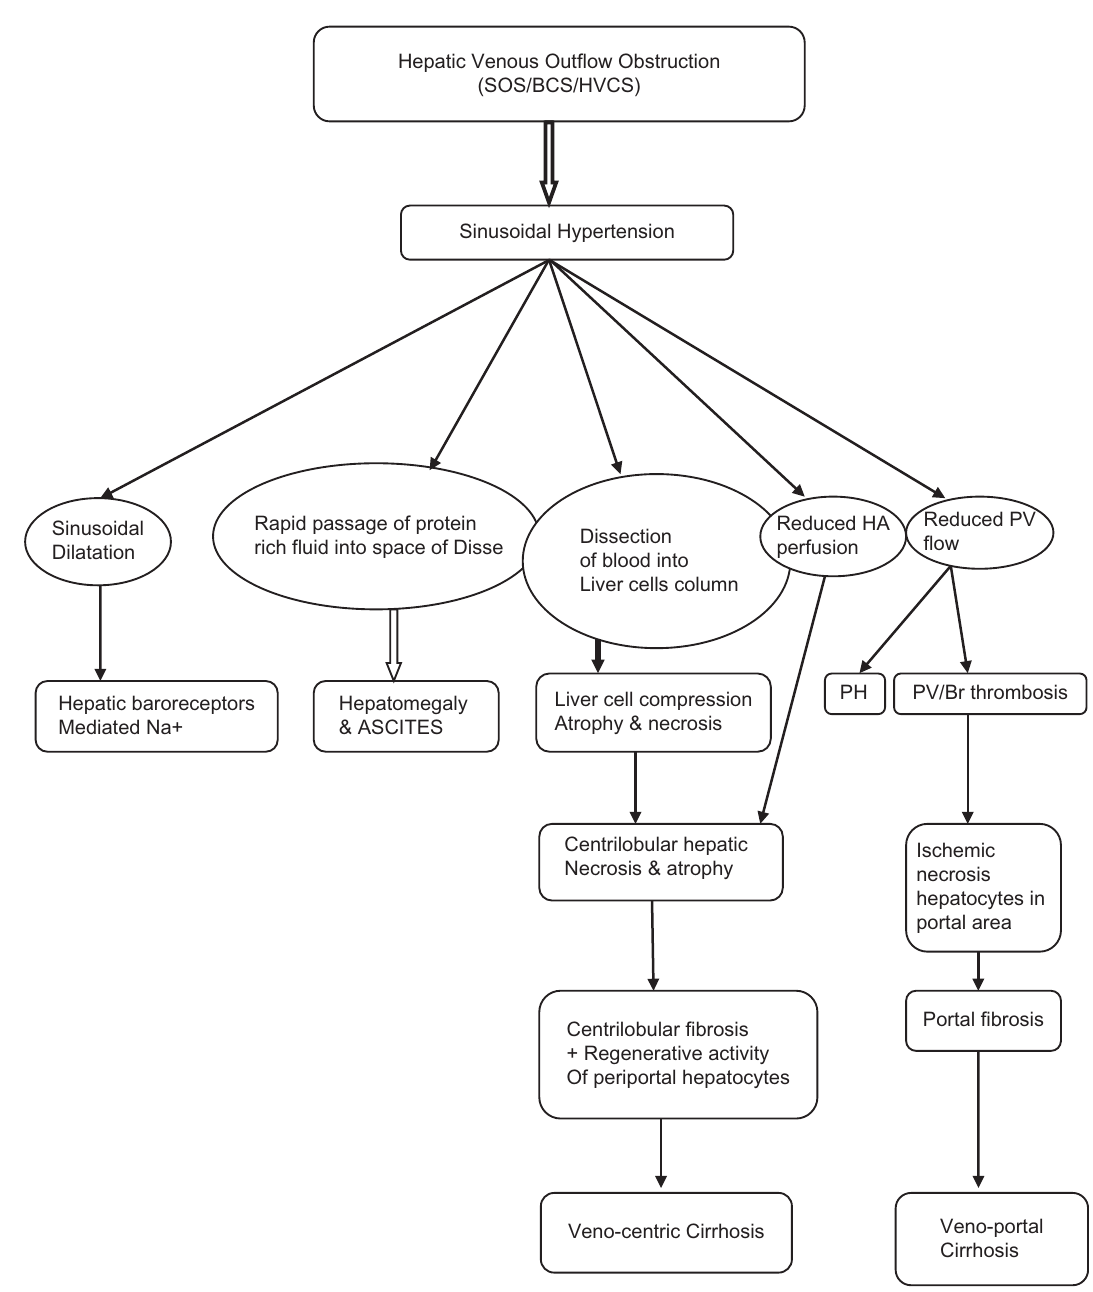
Figure 1. Pathophysiology of sinusoidal